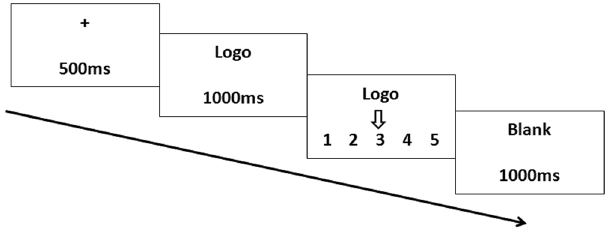
Figure 5. A single trial of the procedure of experiment 2. Participants saw logos directly and ranked the preference degree using a provided